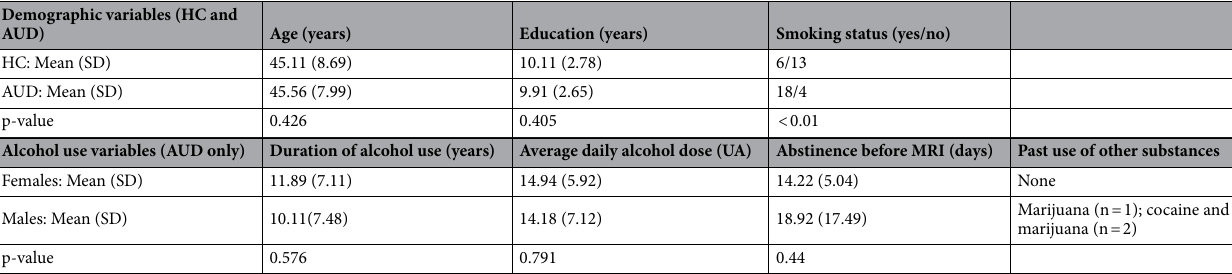
Table 1. Demographics and alcohol use variables. The top table section reports the mean and standard deviation (SD) of demographic variables and smoking status for healthy controls (HC) and patients with alcohol use disorder (AUD), alongside the results of group comparisons with two-sample t-tests and a chi- square test. In the bottom part, duration of alcohol use, average daily alcohol intake and days of abstinence before MRI are reported separately for male and female AUD patients, alongside the results of gender comparisons with two-sample t-tests. Alcohol consumption was calculated as the average number of